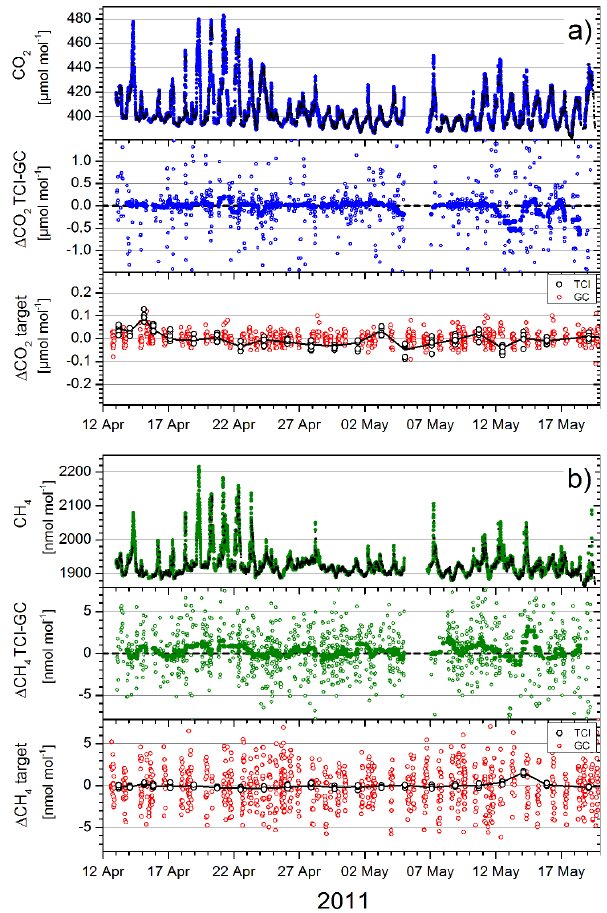
Fig. A1. Upper panels of (a) and (b) : comparison of GC (black) and TCI (blue/green) of CO 2 or CH 4 measurements performed in Heidelberg. Middle panels: individual CO 2 or CH 4 differences between the buffered GC and the smoothed TCI measurements (open symbols); averaged differences (15h running median filter) are shown as filled symbols. The smoothing window is larger, compared to the ICOS Demonstration Sites, to account for the lower comparison frequency of the individual measurements. Lower panels: individual CO 2 or CH 4 GC target injections in red and individual TCI target measurements in